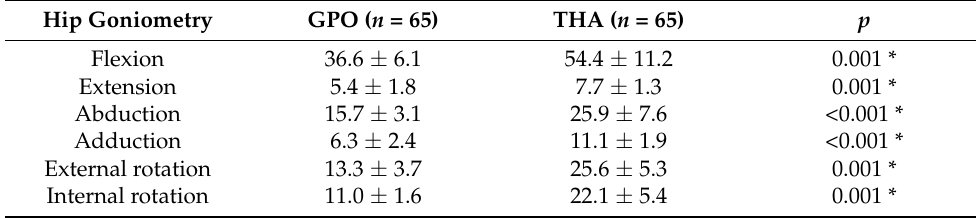
Table 5. Comparison of hip range of motion baseline of the surgical procedure (GPO) and in the late postoperative period after the two-year follow-up of total hip arthroplasty (THA) in older people with unilateral